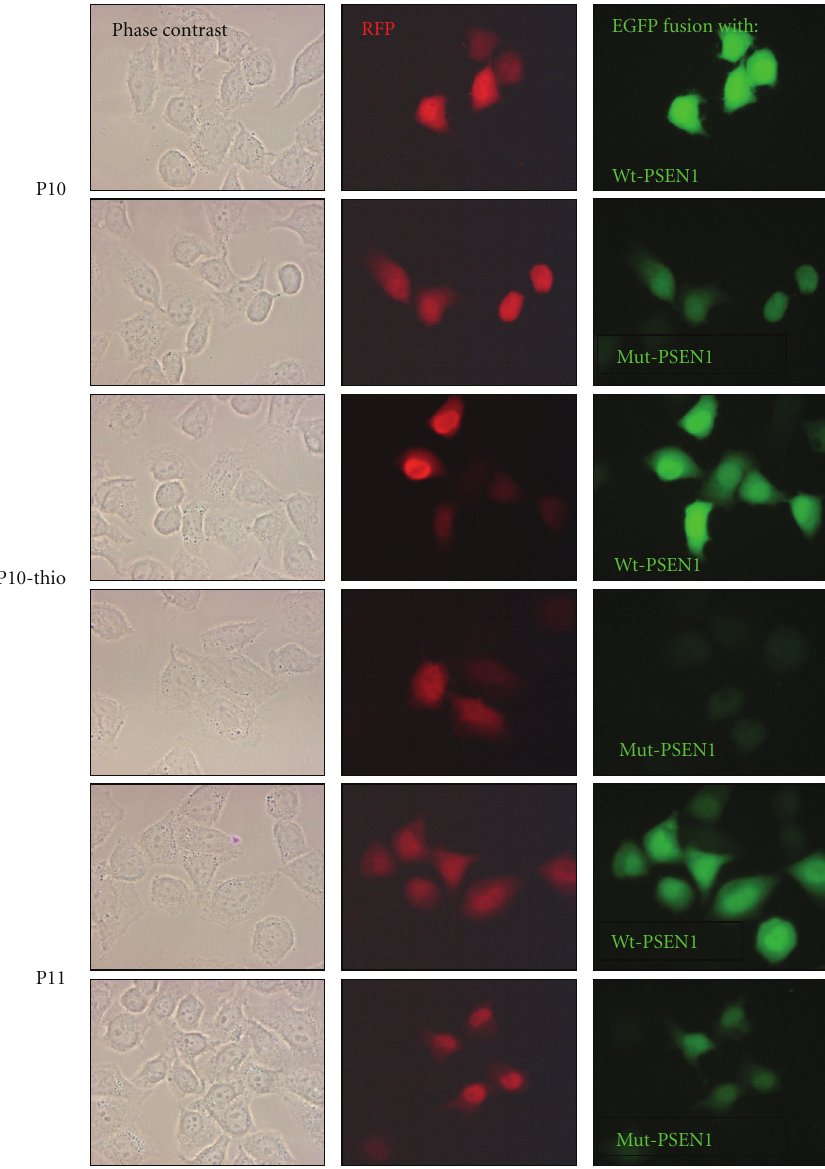
Figure 8: Silencing e ff ects of siRNAs directed towards the Mut-PSEN1 (C → G1174). Fluorescence microscopy image of cells expressing the wild type and mutant fusion protein in the presence of siRNA: P10, P10-thio, and